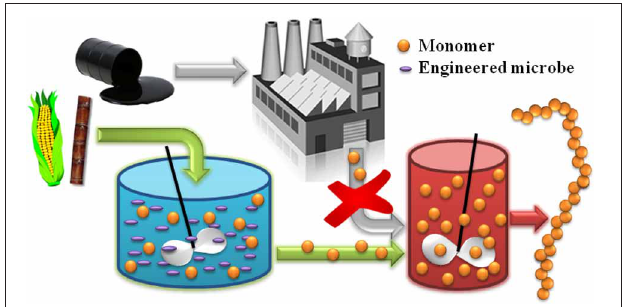
FIGURE 1 | The alternative production of “drop in compatible” monomer compounds from biomass feedstocks enables the development of new classes of bio-derived polymers by coupling emerging biotechnologies with mature polymer processing